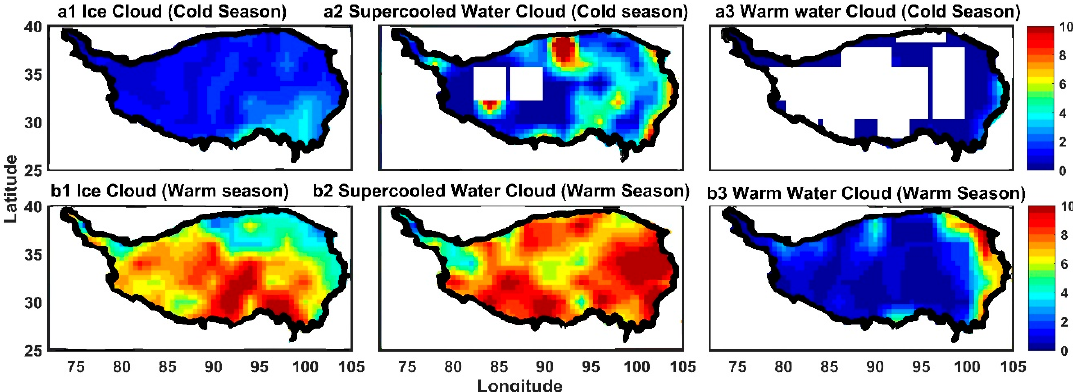
Figure 3. Four-year short-wave cloud optical depth of four different cloud phases over the TP. ( a1 – a3 ) represent the cold season; ( b1 – b3 ) represent the warm season. The spatial resolution is a 0.5° × 0.5° grid (Here, ice clouds, liquid clouds refer to the case of the single-layer clouds. Part of the data for water clouds during the cold season is missing).